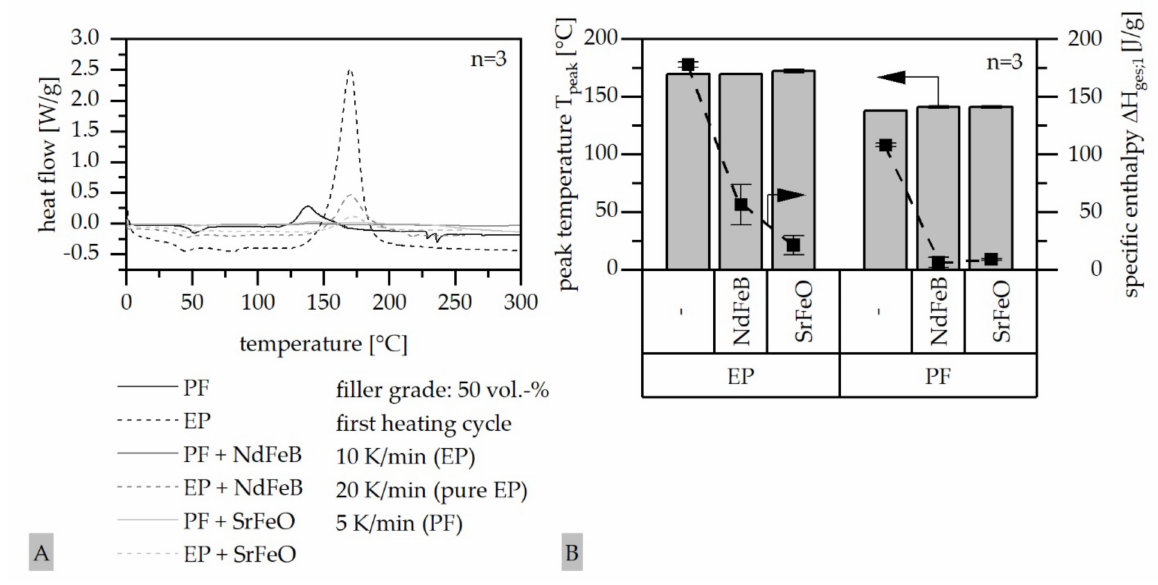
Figure 5. Route of DSC measurement ( A ) and peak temperature T peak as well as specific enthalpy ∆ H ges;1 ( B ) in the first heating cycle relative to the material system (SrFeO: strontium-ferrite-oxide; NdFeB: neodymium-iron-boron; PF: phenolic resin; EP: epoxy